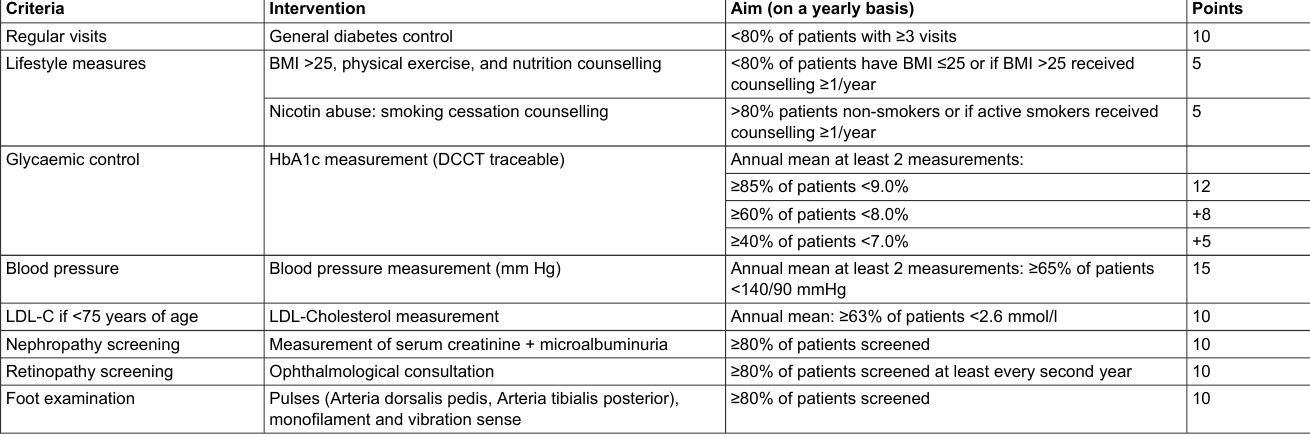
Table 2: SGED Score [26, 27]: suggested target: ≥70/100 points.